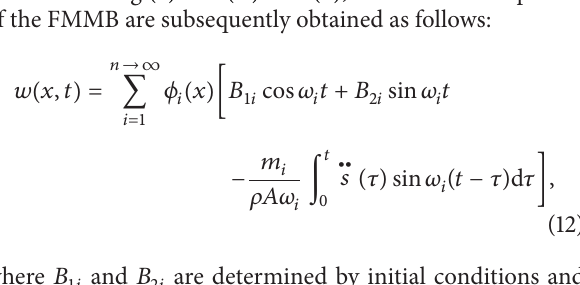
Figure 3: Force and moment analysis of infinitesimal element in the flexible